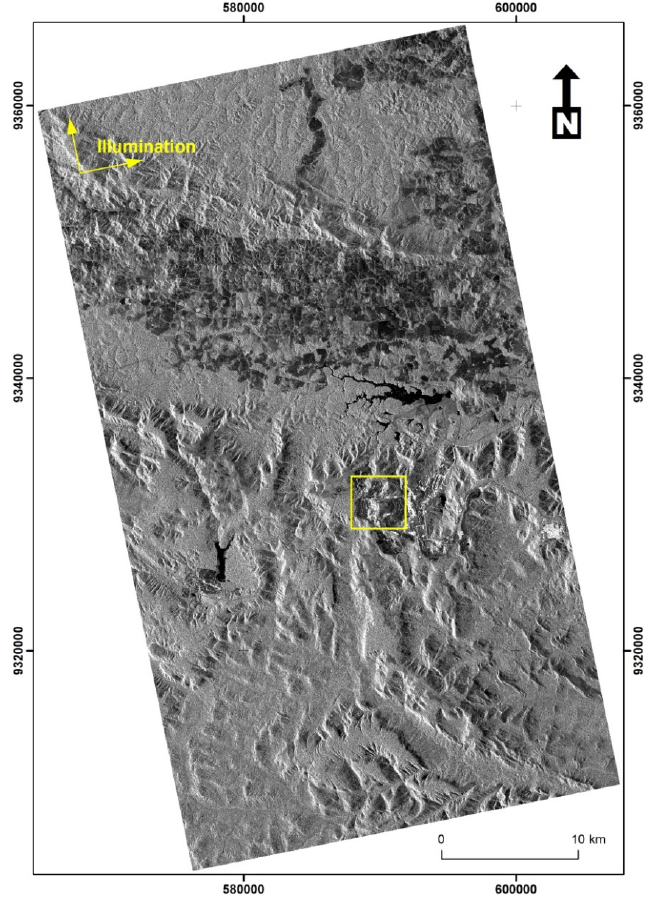
Figure 3. Footprint of TSX-1 with indication of the N4W mine and its surroundings.